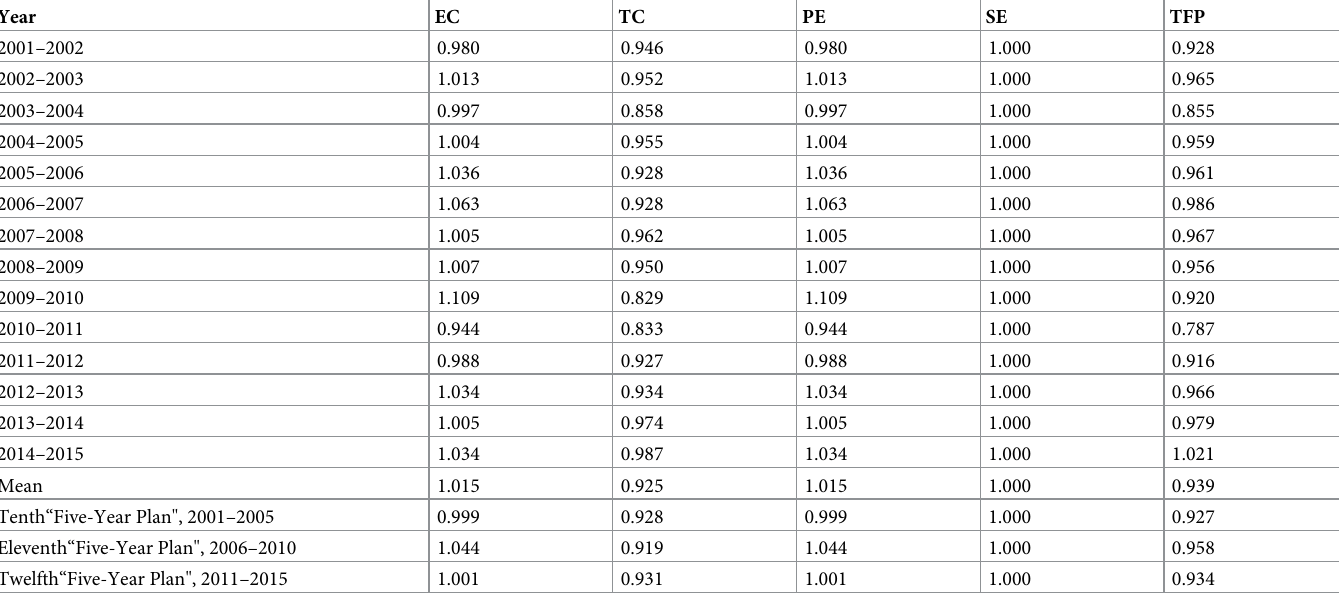
Table 4. Malmquist index of ecological efficiency in Xinjiang from 2001 to